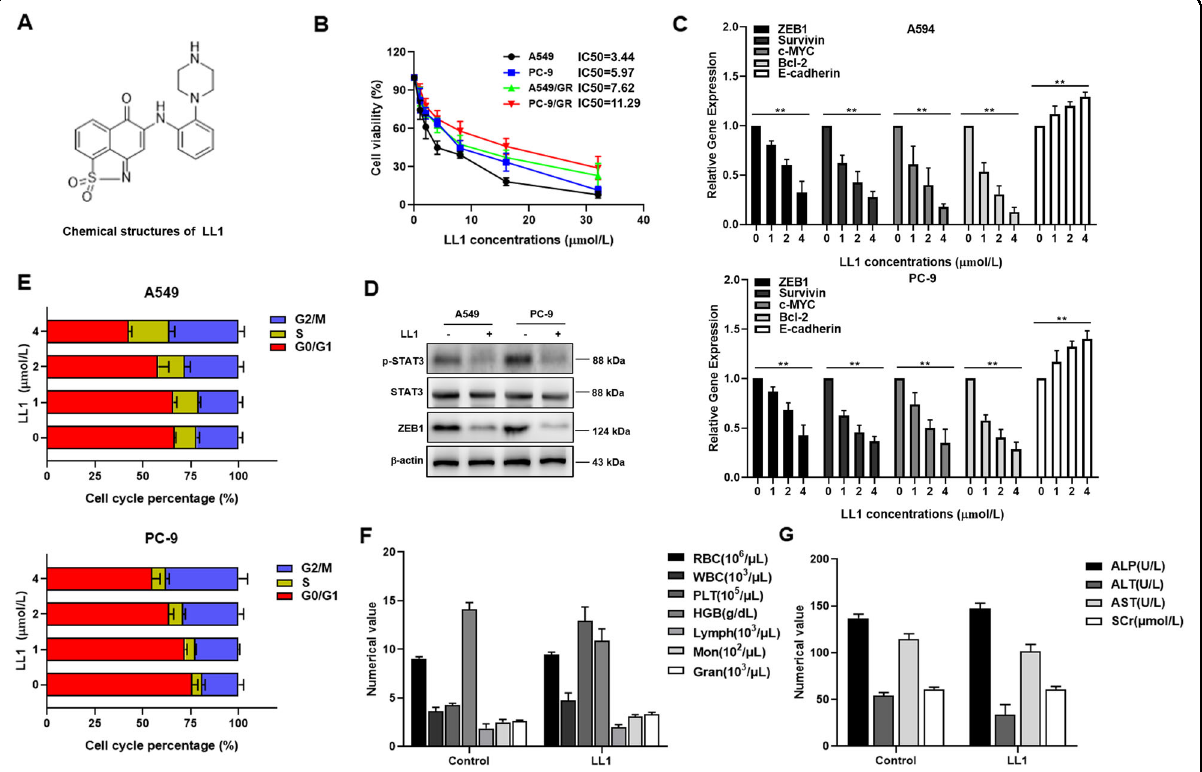
Fig. 4 LL1 speci fi ed block the activation of STAT3. A Chemical structures of novel molecules of LL1. B A549 and PC-9 cells were treated with the indicated doses (0, 1, 2, 4, 8, 16, 32 μ mol/L) of LL1 for 24h. Cell viability was determined using the MTT assay. C qRT-PCR analysis of ZEB1, Bcl-2, c-myc, E-cadherin and survivin in A549 and PC-9 cells after LL1 treatment for 24h. Data were mean±SD, n = 3. **p value < 0.01. D Protein levels of ZEB1, p-STAT3, and STAT3 were detected by western blot in A549 and PC-9 cells treated with LL1 (2 μ mol/L). E The percentage of cell cycle distribution for A549 and PC-9 cells treated with indicated concentrations of LL1. F , G Complete blood count and biochemical tests in the control or LL1 (5mg/kg) treated